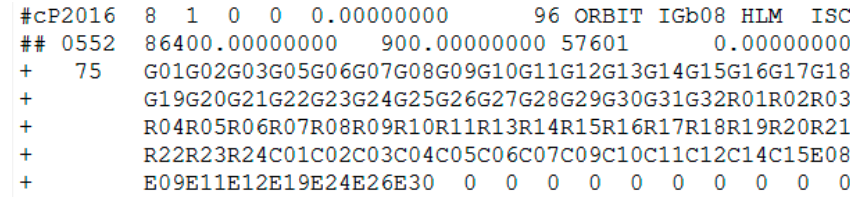
Table 2. Results of orbital maneuver detection in 2016 for BeiDou GEO/IGSO satellites. (Unit: hour:minute:second).